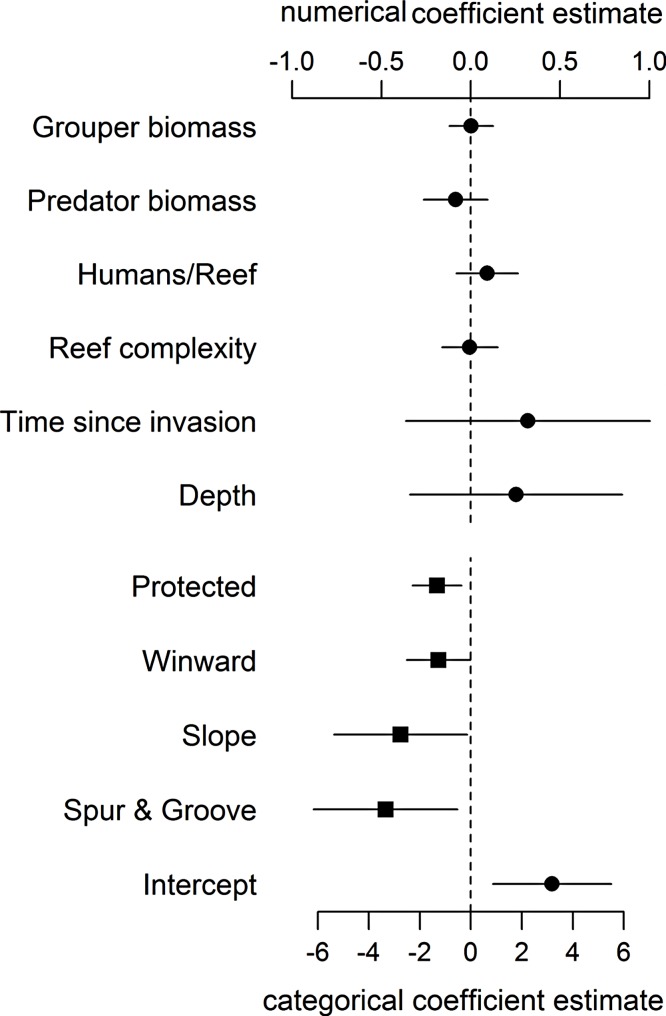
Coefficient estimates (±95% confident intervals) showing the effect of different variables on lionfish abundance.Lionfish counts were modeled with a generalized linear mixed effect model using the automatic differentiation model builder (glmmADMB) based on a negative binomial distribution type 1 and log link. Abundance values were obtained by adding the log of survey area as offset in the model. Numerical variables (top axis, circles) and categorical variables (bottom axis, squares) are on different scale for easy visual representation as the magnitude effects of the former are relatively smaller. For full summary of the model see Table S3.